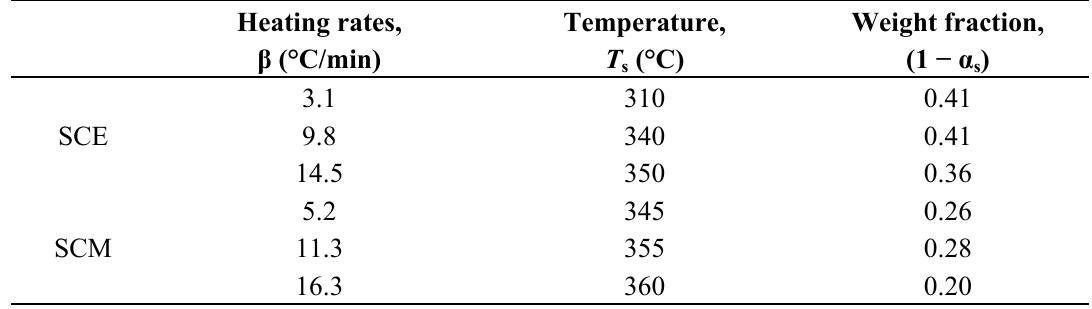
Table 3. Weight fraction and temperature at which the inflection occurs in weight loss